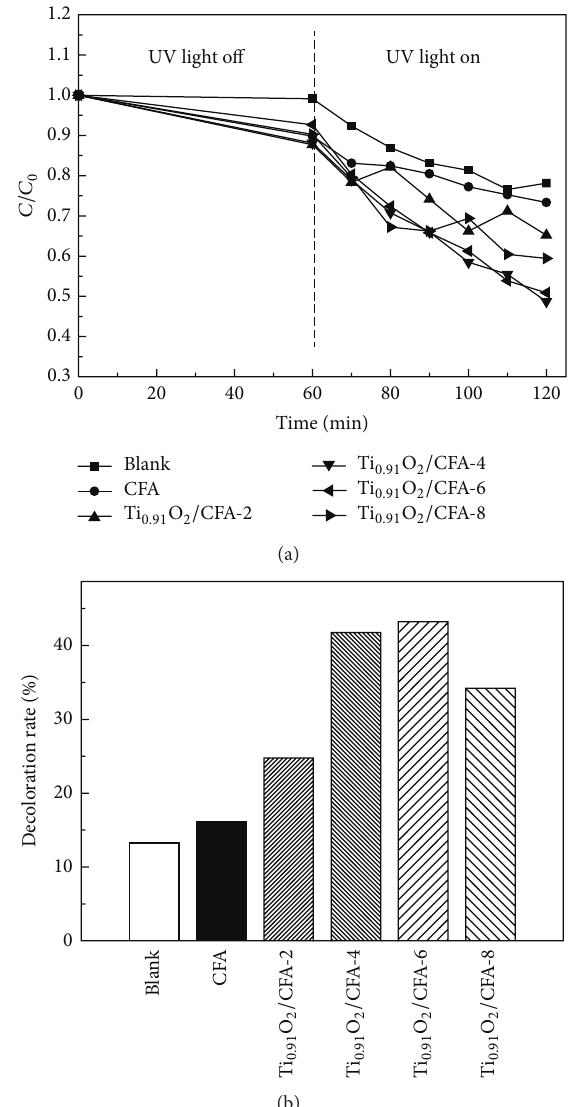
Figure 7: Photocatalytic activities of all